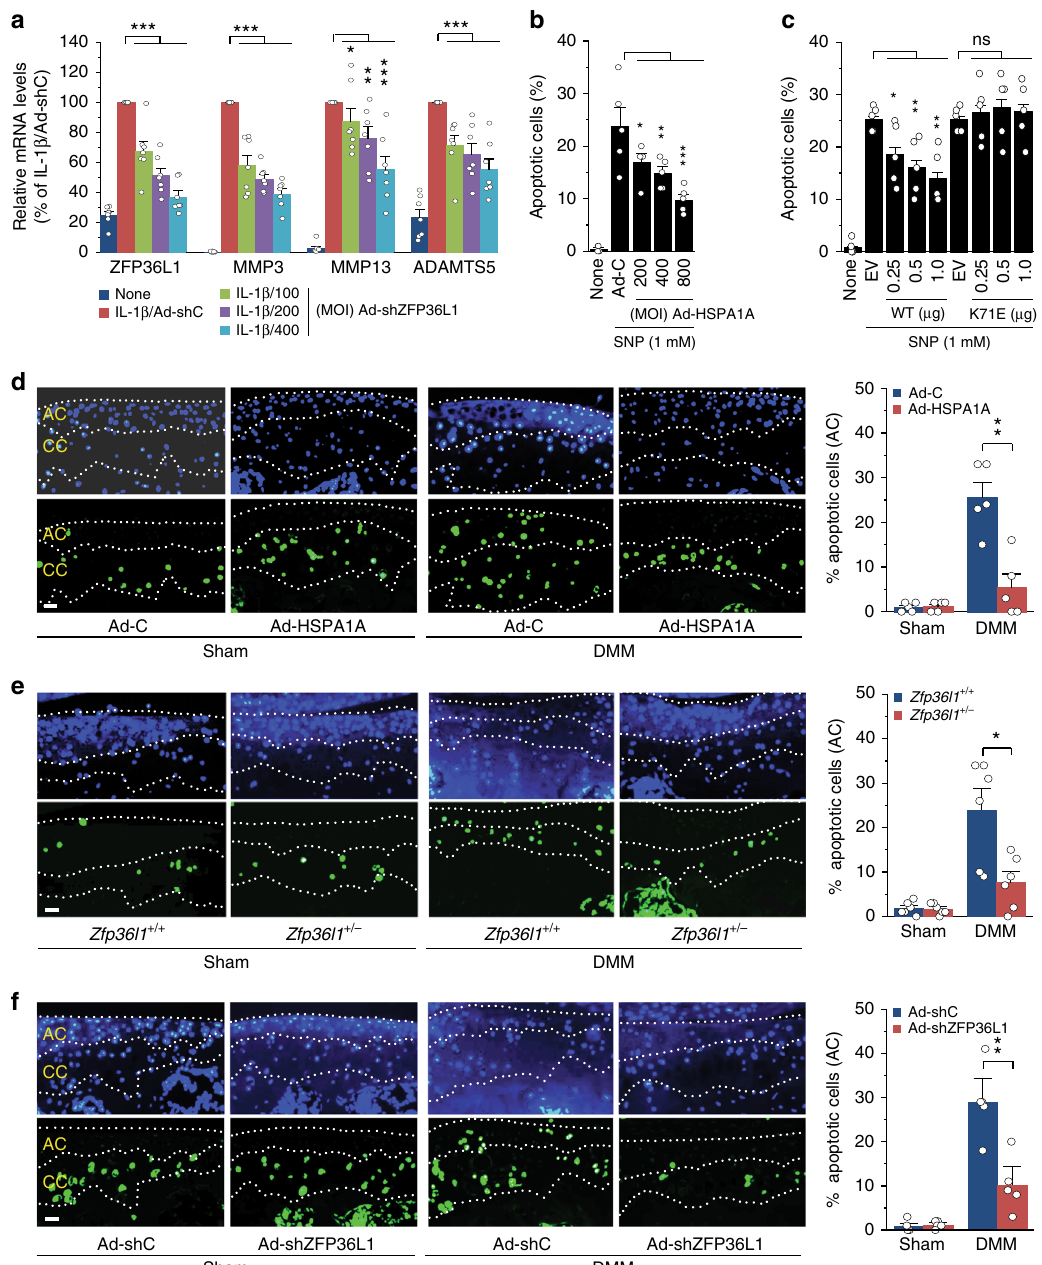
Fig. 6 HSPA1A inhibits chondrocyte apoptosis. a qRT-PCR analysis ( n = 7) of matrix-degrading enzymes in chondrocytes treated with IL-1 β and infected with 400 MOI of control virus or the indicated MOIs of Ad-shZFP36L1. b , c Chondrocytes were infected with Ad-C or Ad-HSPA1A ( b ) or transfected with empty vector (EV, 1 μ g) or vectors encoding WT-HSPA1A or K71E-HSPA1A ( c ) and left untreated or exposed to the NO donor, SNP, for 6 h. Apoptotic chondrocytes were identi fi ed and quanti fi ed by TUNEL staining ( n = 5). d – f Detection and quantitation of apoptotic chondrocytes in calci fi ed cartilage (CC) and articular cartilage (AC) of sham- or DMM-operated mice subjected to IA injection with Ad-C or Ad-HSPA1A ( n = 5 mice per group) ( d ), sham- or DMM-operated Zfp36l1 + / − and WT mice ( e ; n = 6 mice per group), or sham- or DMM-operated mice subjected to IA injection with Ad-shC or Ad- shZFP36L1 ( f ; n = 5 mice per group). Means ± s.e.m. with one-way ANOVA ( a – c ) and two-tailed t -test ( d – f ). * P < 0.05, ** P < 0.005, and *** P < 0.0005; ns, not signi fi cant. Scale bar: 50 μ